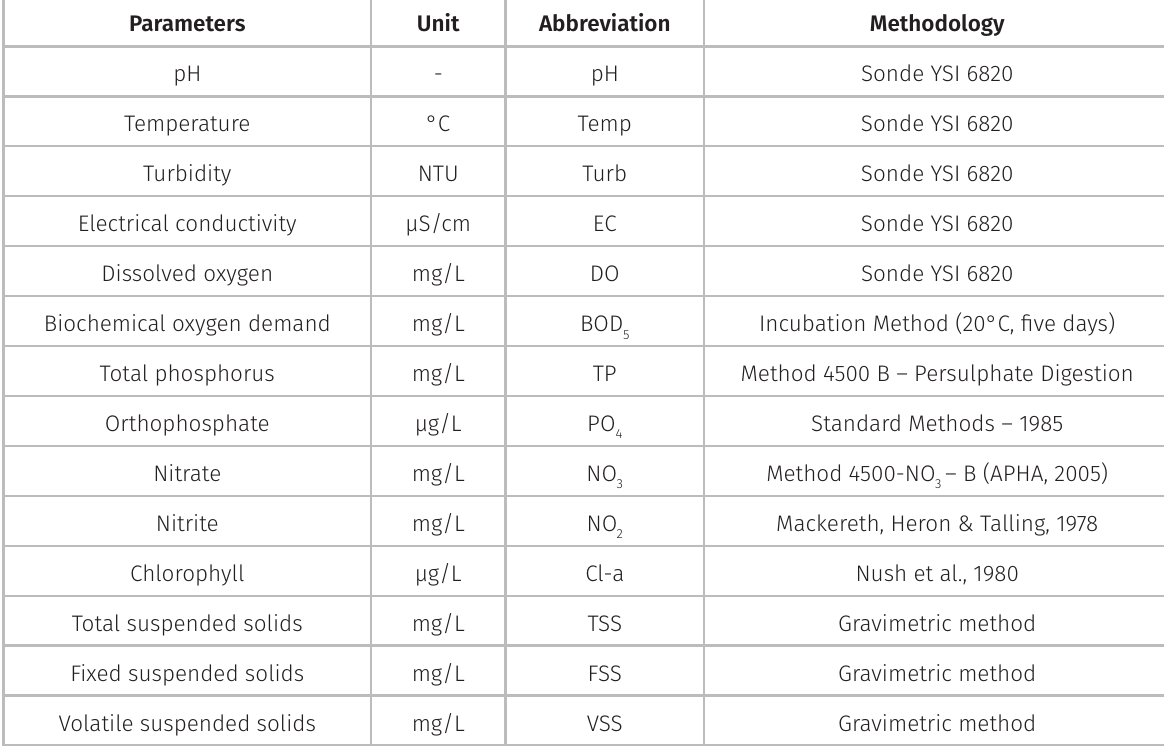
Table II. Methodologies for physical-chemical parameters